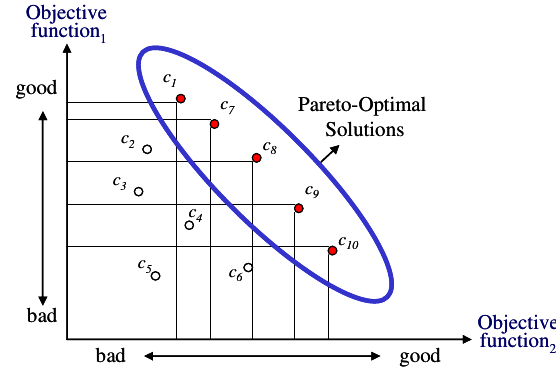
Fig. 2. An example for the Pareto optimal solutions